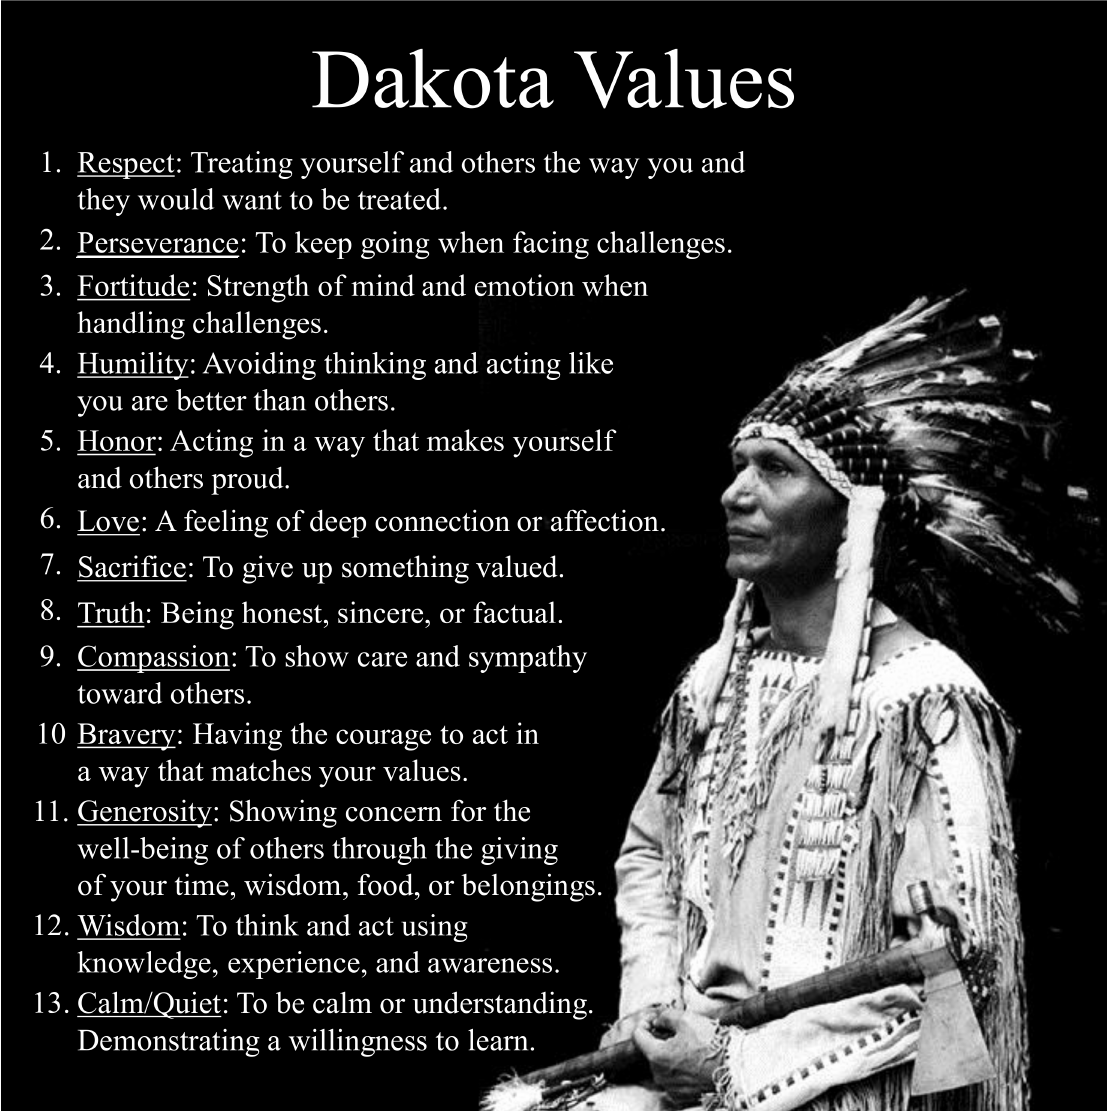
Figure 4. Traditional Dakota Values